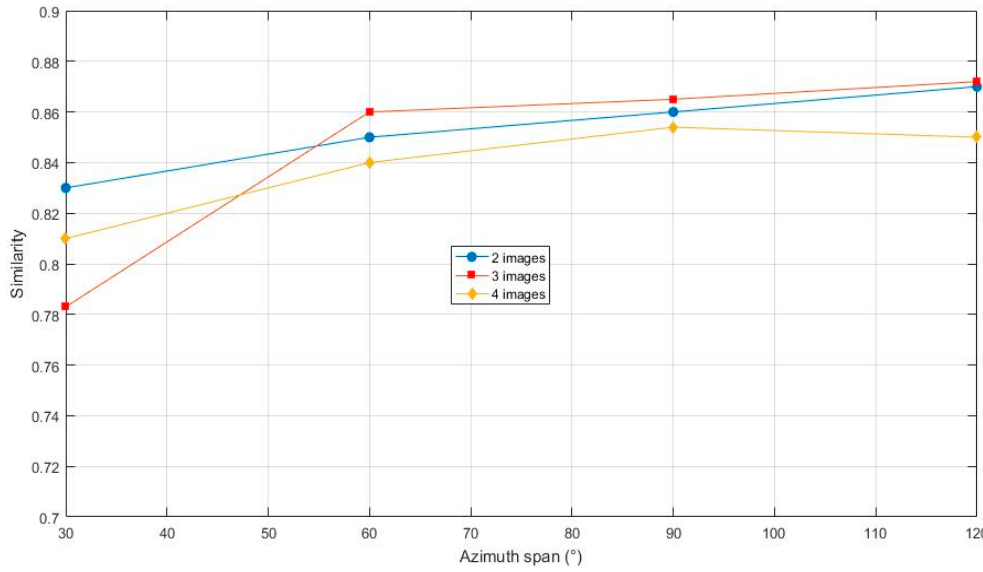
Figure 6. Results of different number of views.